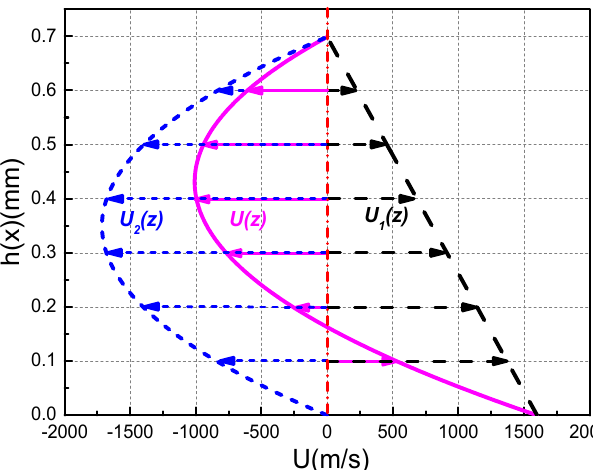
Figure 8. Velocity decomposition curves of metal liquid film at the exit of the contact surface at U = 1600 m / s.